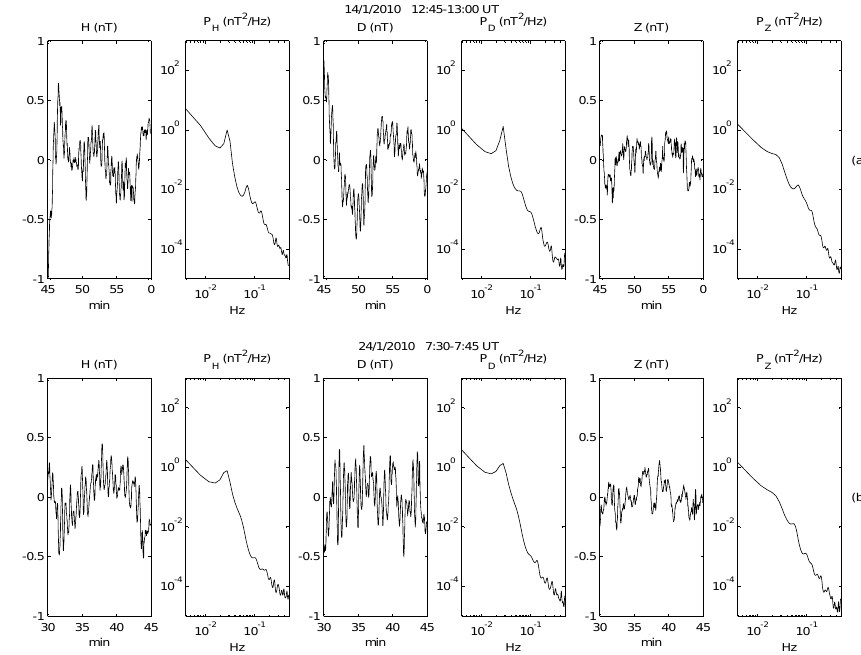
Figure 1. Two examples of natural signals in the period of interest and the corresponding power spectra.